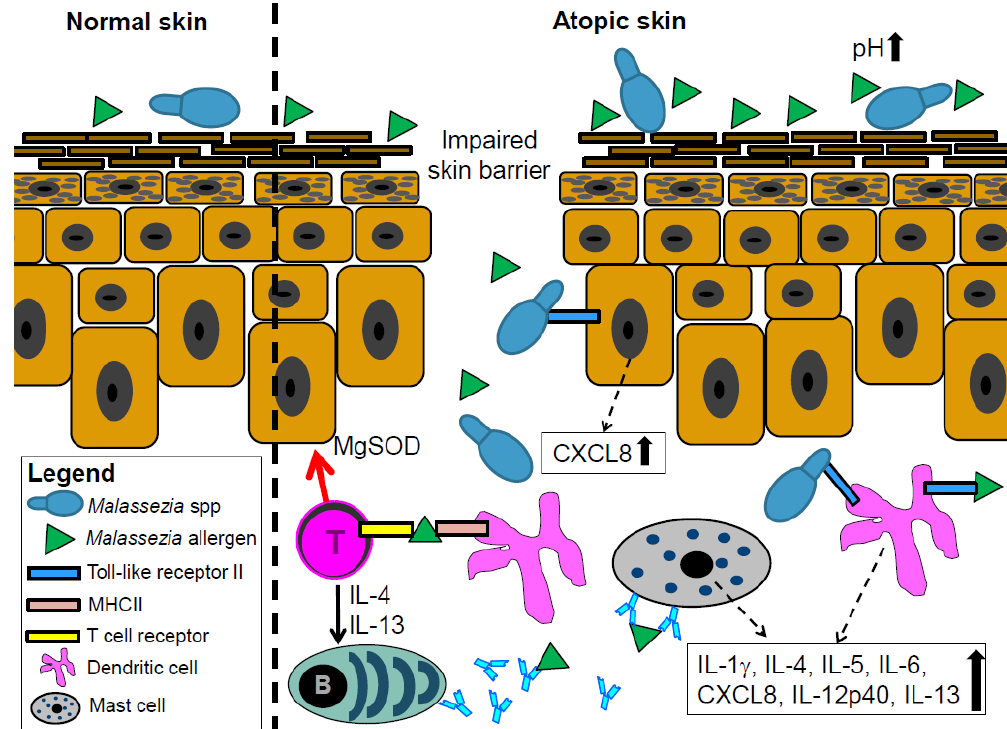
Figure 2. Proposed mechanisms by which Malassezia spp. contributes to skin inflammation in atopic dermatitis (AD) patients. The increased pH in atopic skin contributes to increased allergen release by Malassezia spp. These allergens, supposedly together with whole Malassezia spp. cells, penetrate the epidermis through the disturbed skin barrier in AD patients. Malassezia spp. cells and their allergens may be recognized by toll-like receptor 2 expressed on keratinocytes and dendritic cells which elicits the release of pro-inflammatory cytokines. Malassezia spp. components elicit the production of Malassezia spp.-specific IgE antibodies through the dendritic cells and T cell-mediated activation of B